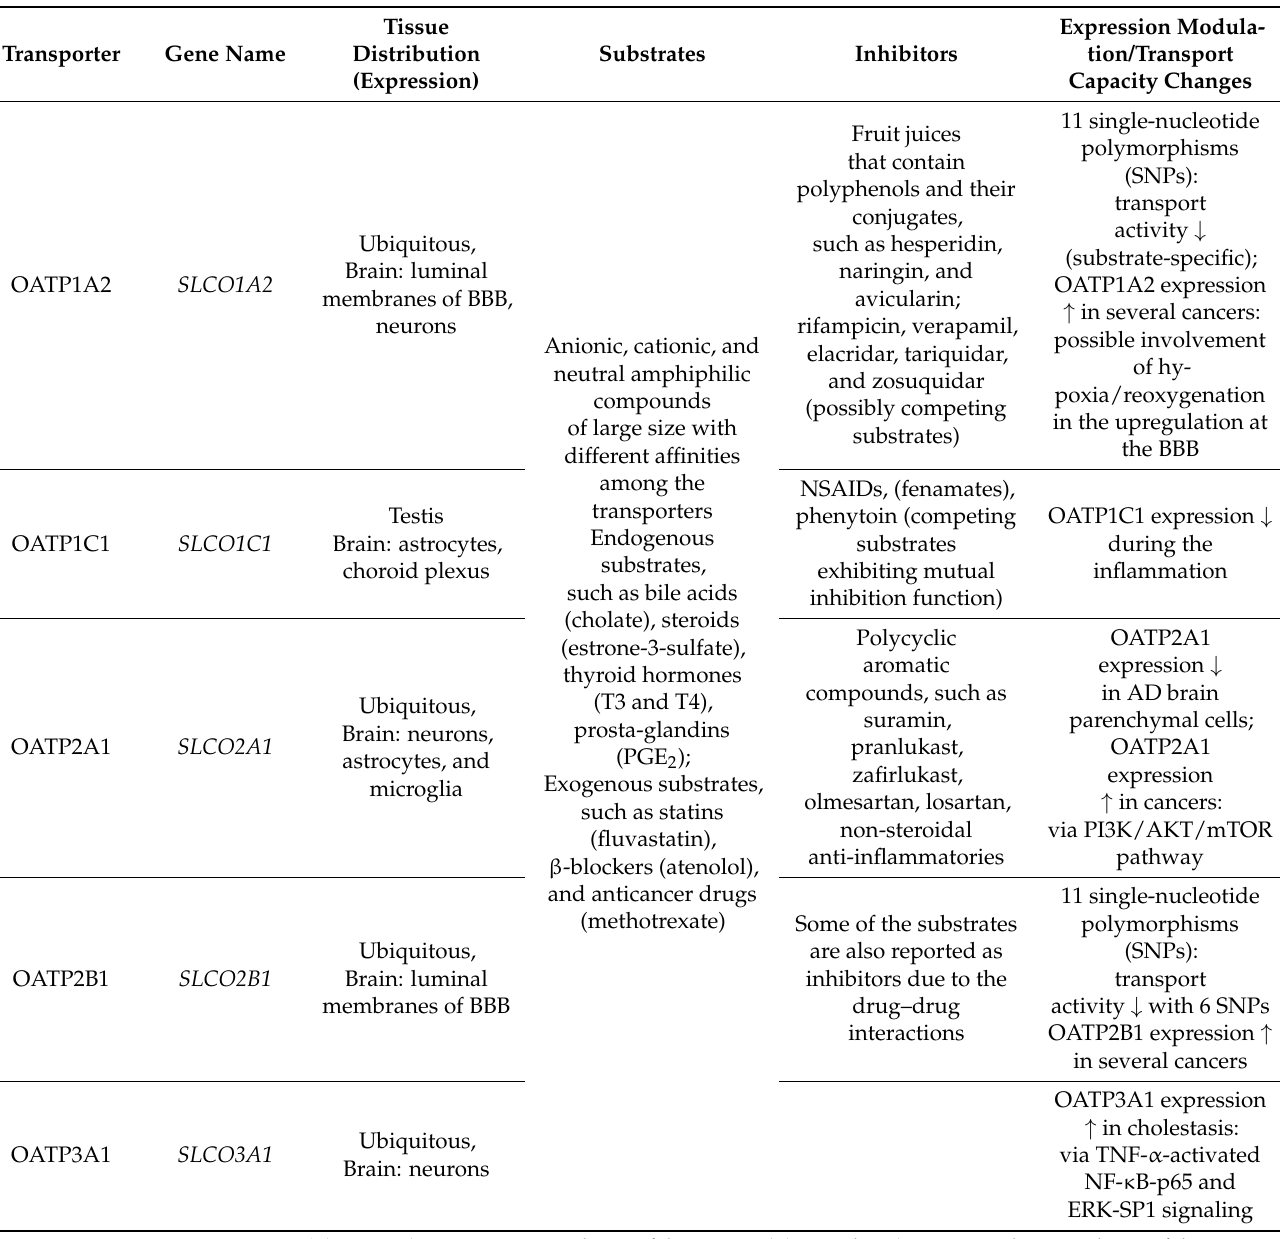
Table 5. Tissue distribution, substrates, inhibitors, and expression/function modulators of selected members of the